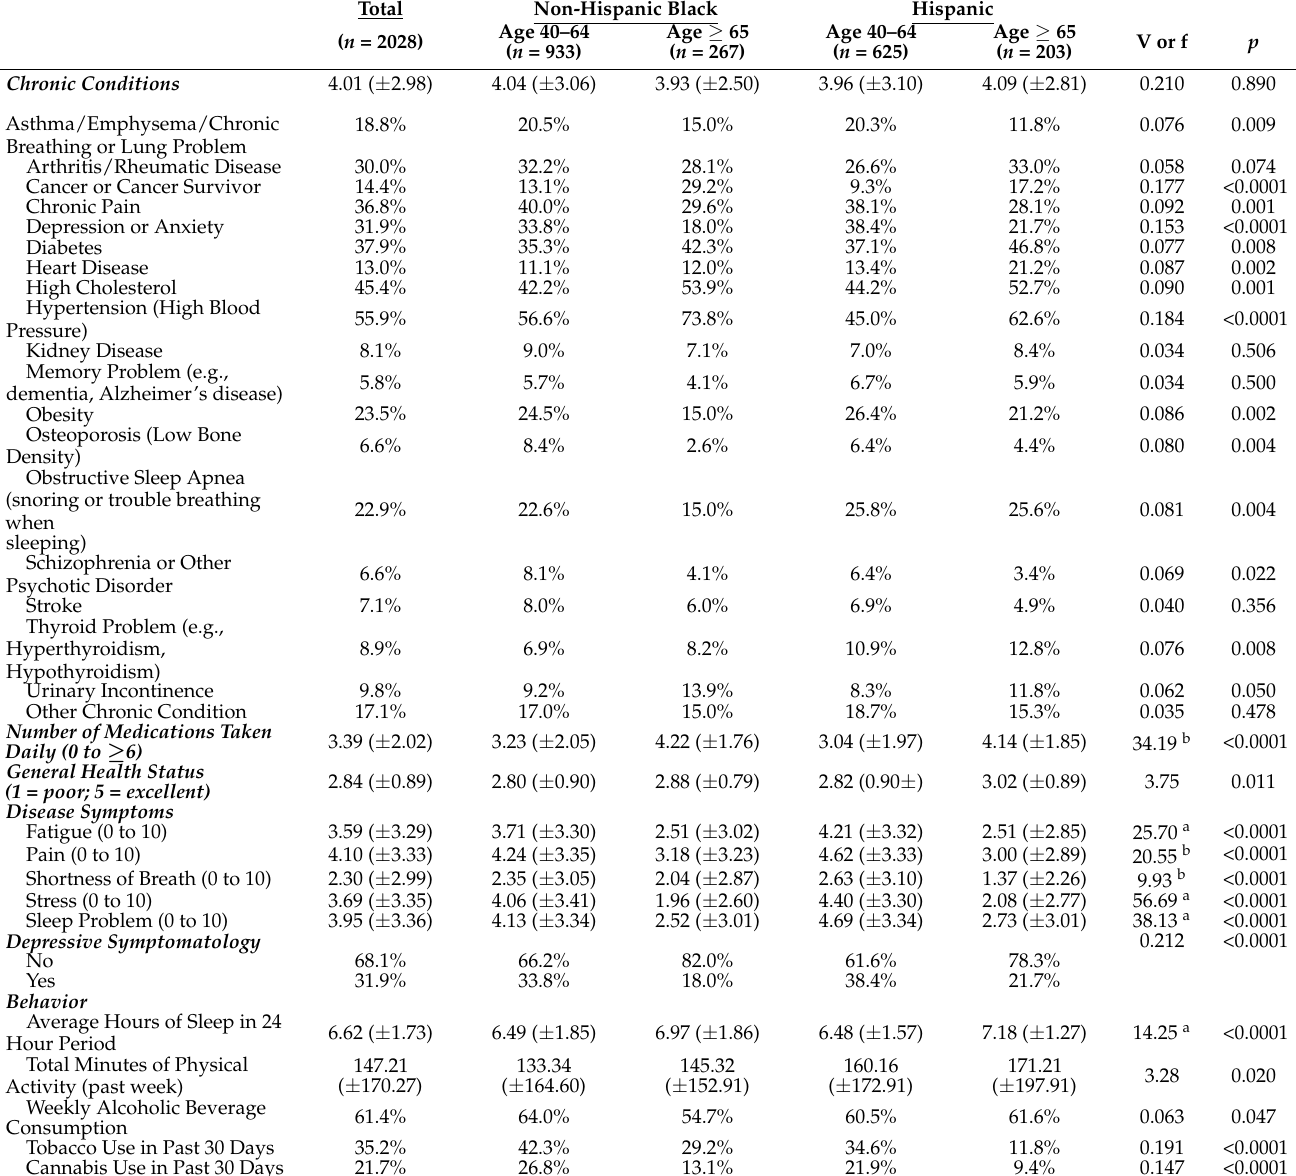
Table 2. Patient context: Health status by race/ethnicity and age